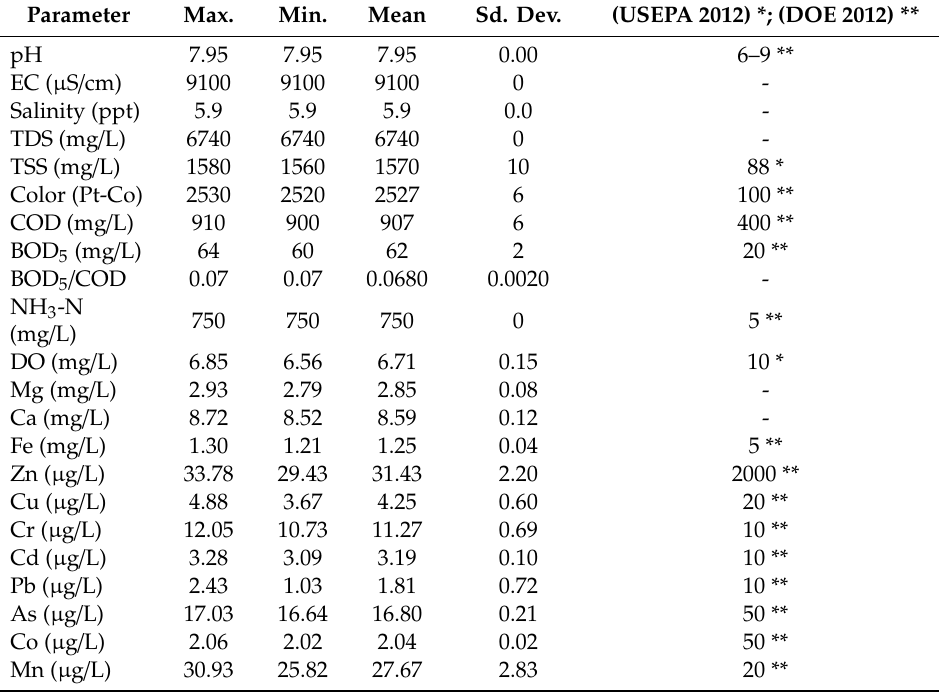
Table 1. Characteristics of the raw leachate collected from the Ampar Tenang closed landfill (ATCL). Parameter Max. Min. Mean Sd.